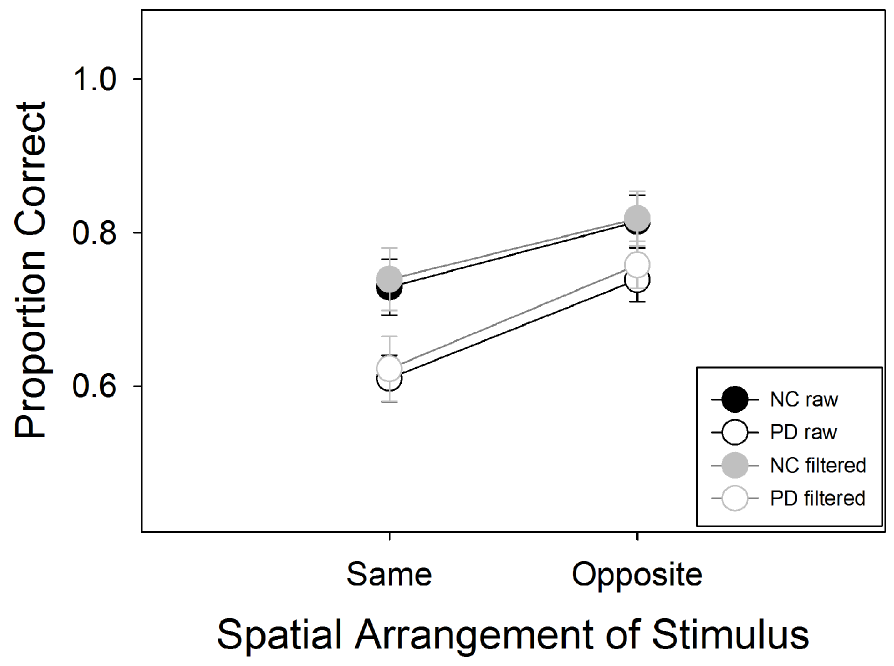
Fig 5. Results of Experiment 2. PD were less accurate than NC overall in both the raw dataset, and the filtered one based only on trials where subjects maintained fixation.